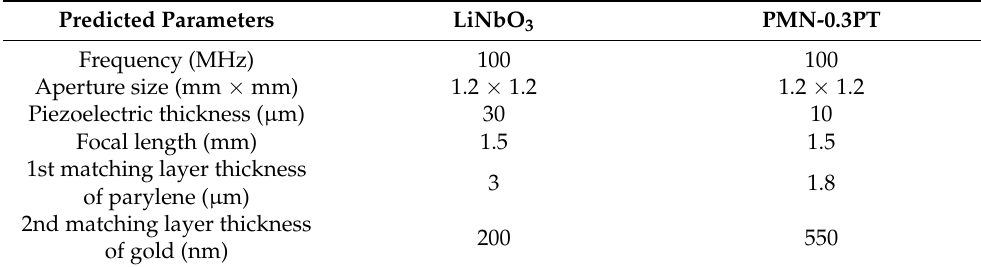
Table 3. Predicted parameters on the basis of the KLM model for the transducer design. Predicted